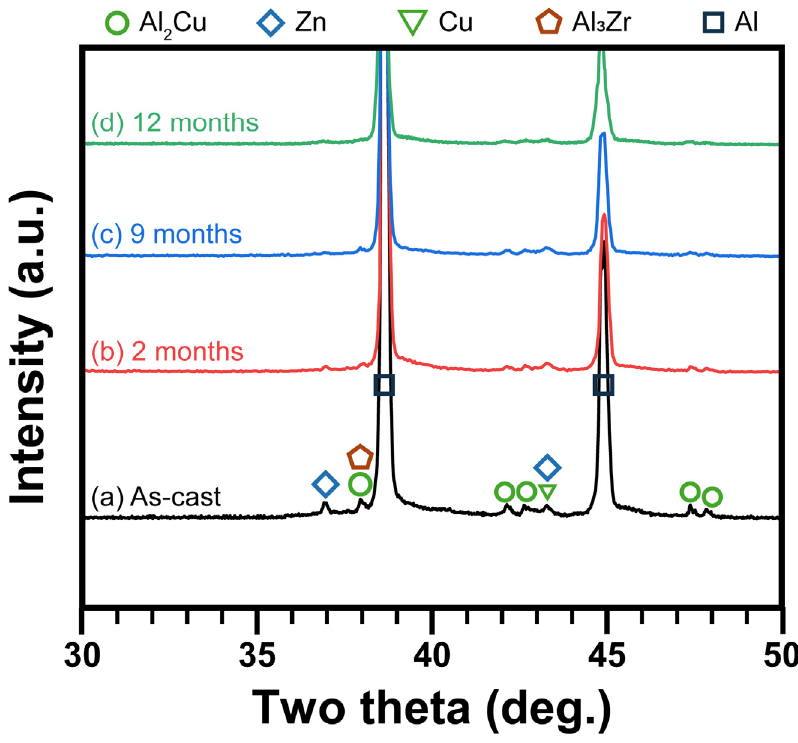
Figure 2. XRD profiles of the Al-20Zn-3Cu alloy at different natural aging times.